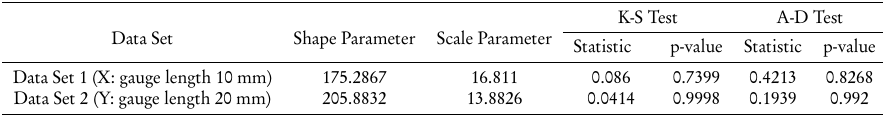
MLEs, K-S and A-D tests for real data sets assuming different scale